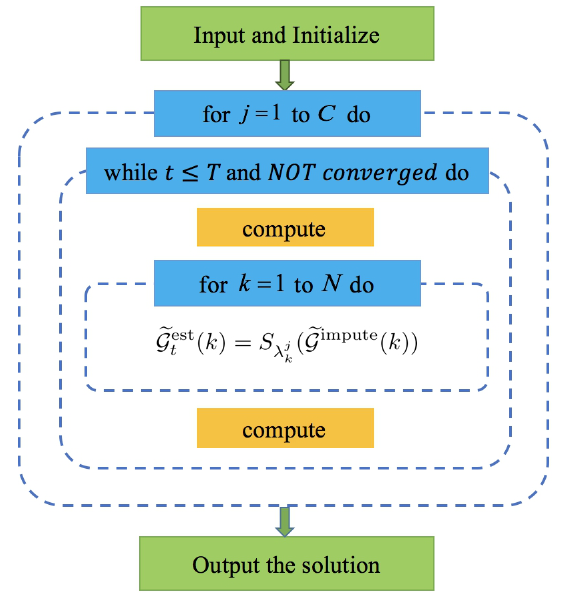
Figure 2. The overall flow chart of the convolutional imputation